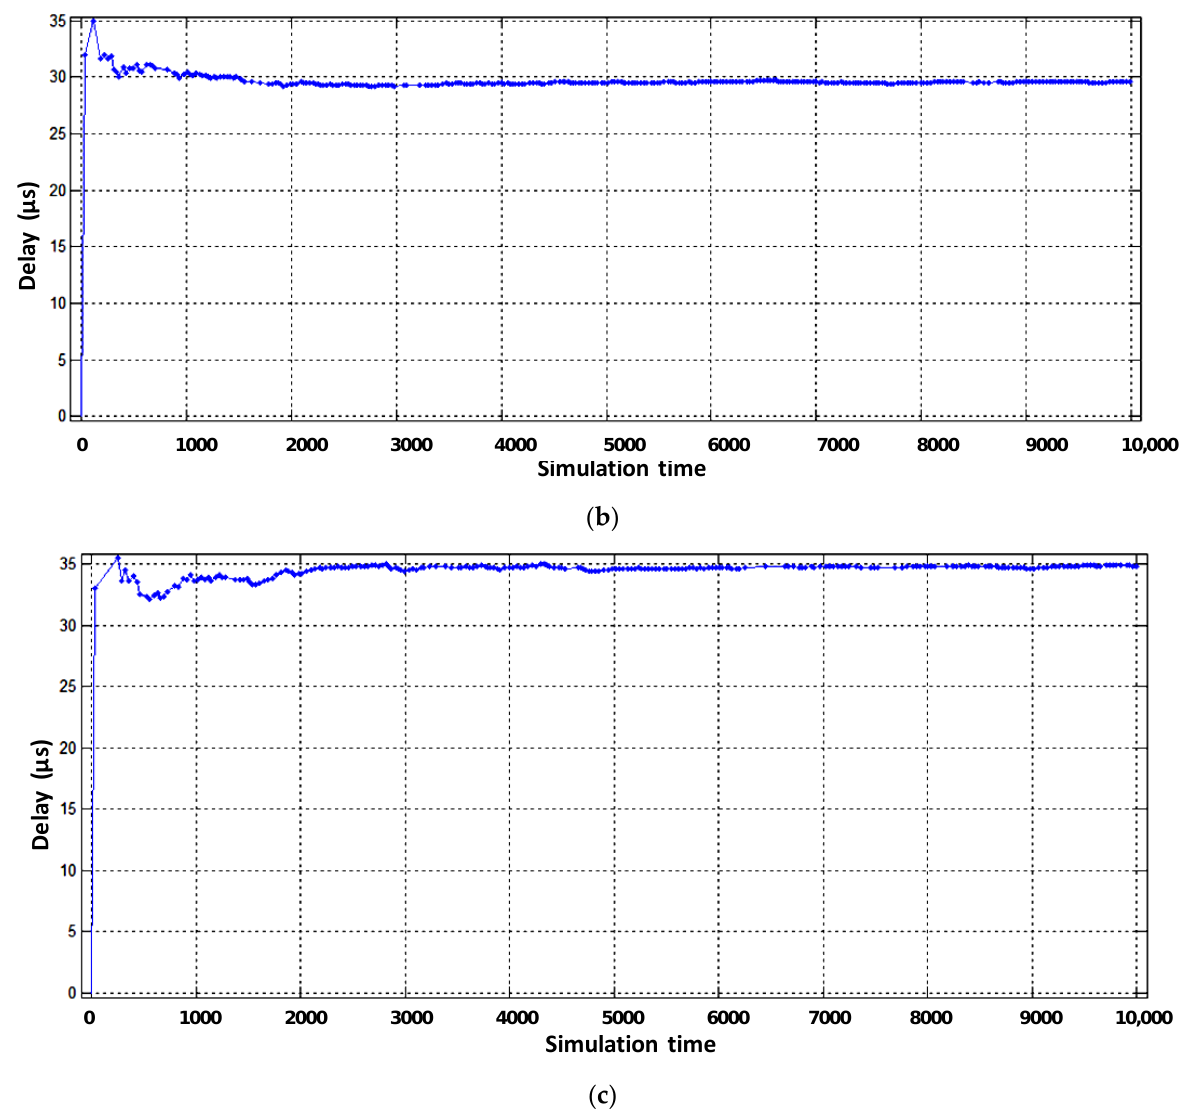
Figure 13. The sum of processor and interface packet latency of the virtual router when serving flow: ( a ) video, ( b ) voice, ( c ) data.